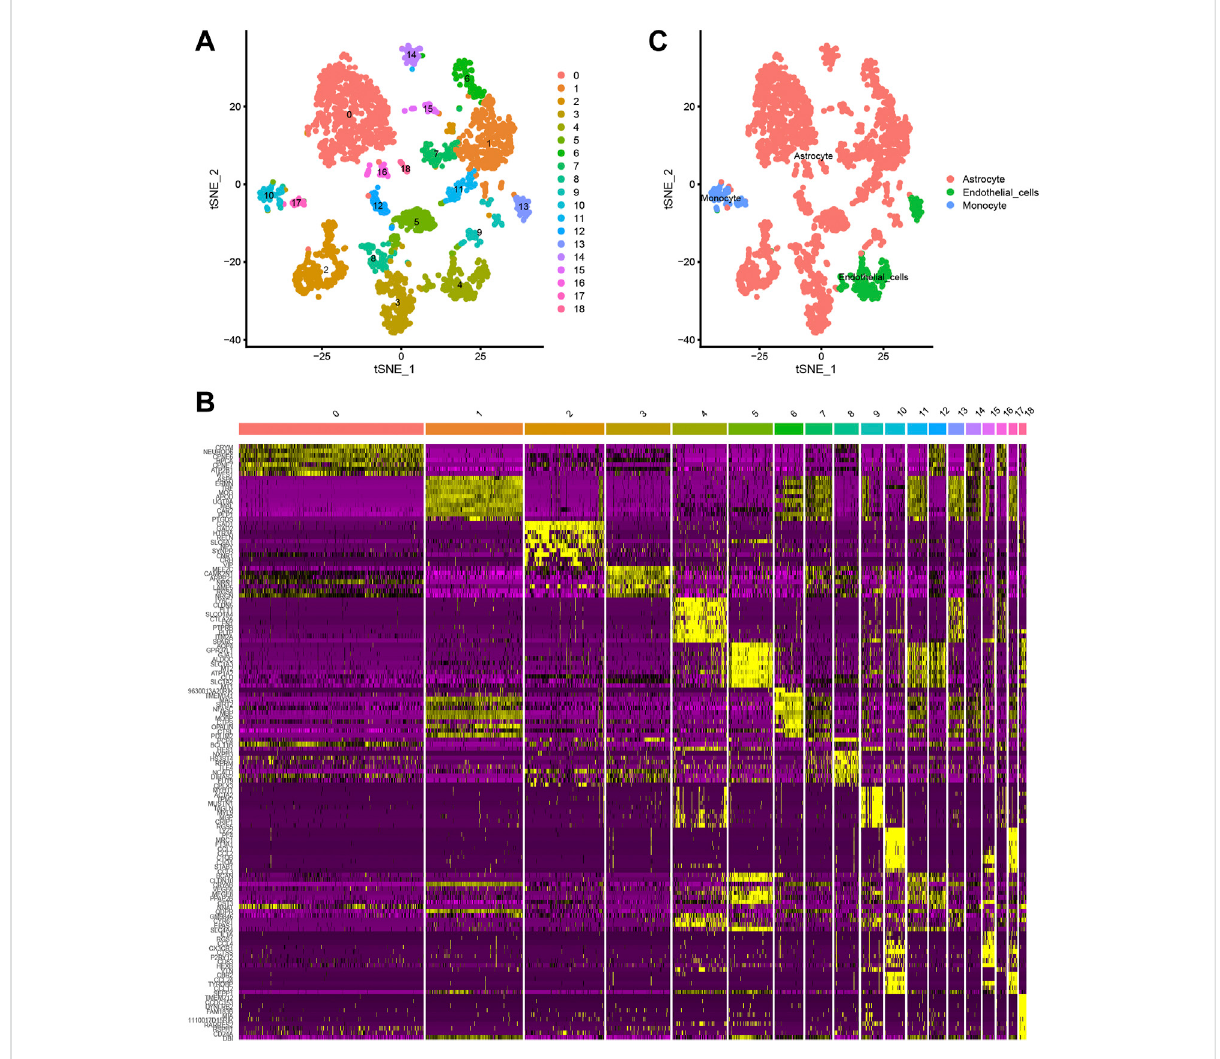
FIGURE 1 (A, B) The t-distributed stochastic neighbour embedding (t-SNE) technique classi fi es 18 cell clusters using the relevant PCs identi fi ed via principal component analysis. (C) A total of 18 clusters were identi fi ed using differential analysis. The top 10 marker genes in each cell cluster are shown in the